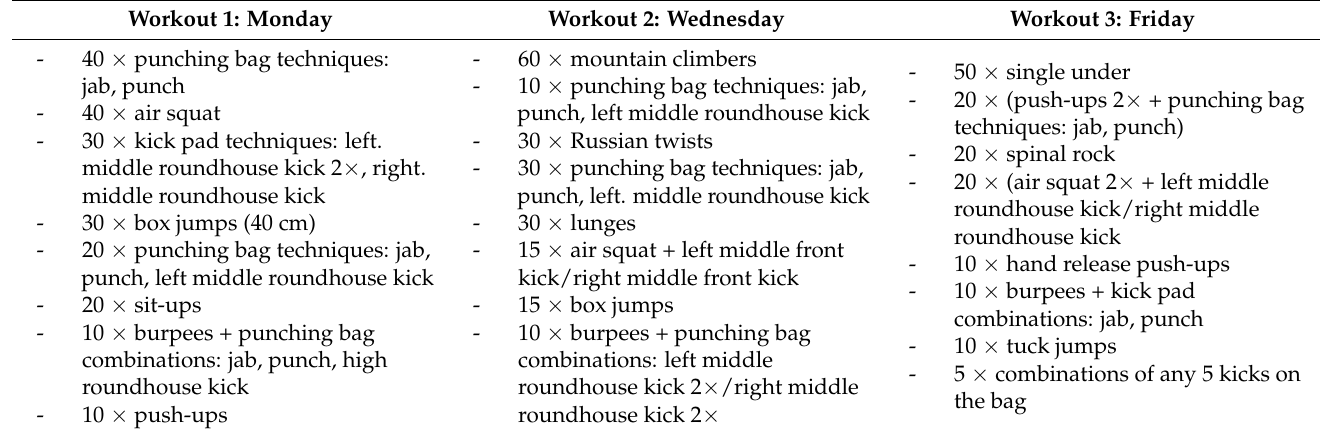
Table 2. The experimental training program used in the